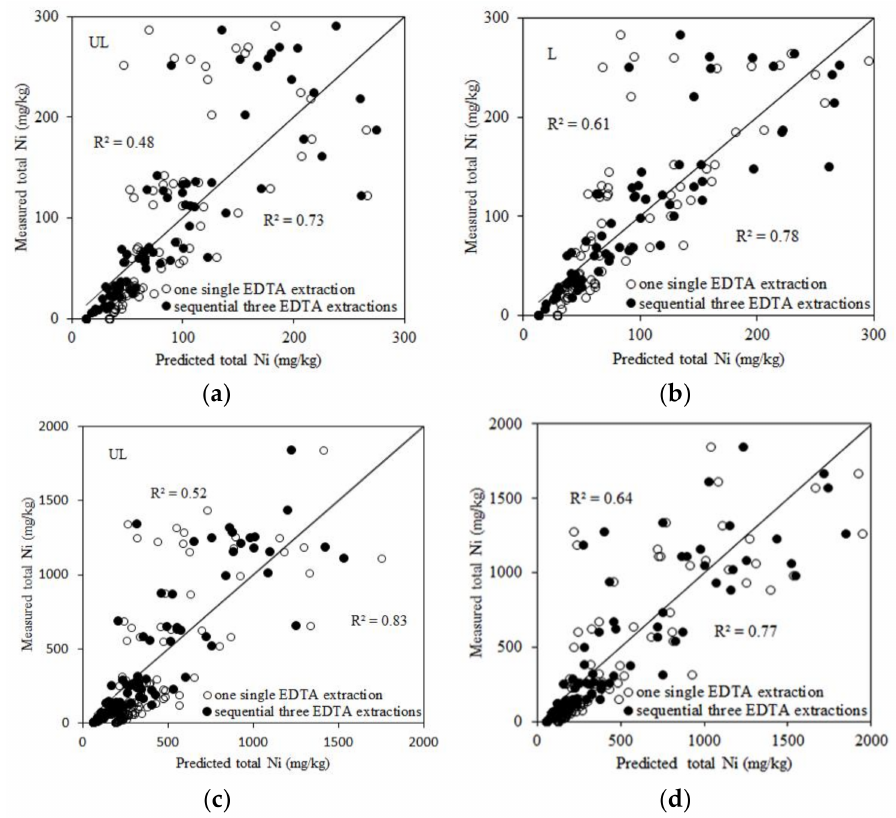
Figure 1. The relationships between the measured and predicted total Ni. ( a ) calculated from Equations (1) and (3) in Table 4; ( b ) from Equations (5) and (7) in Table 4; ( c ) from Equations (9) and (11) in Table 4; and ( d ) from Equations (13) and (15) in Table 4. UL and L represent unleached and leached soils,